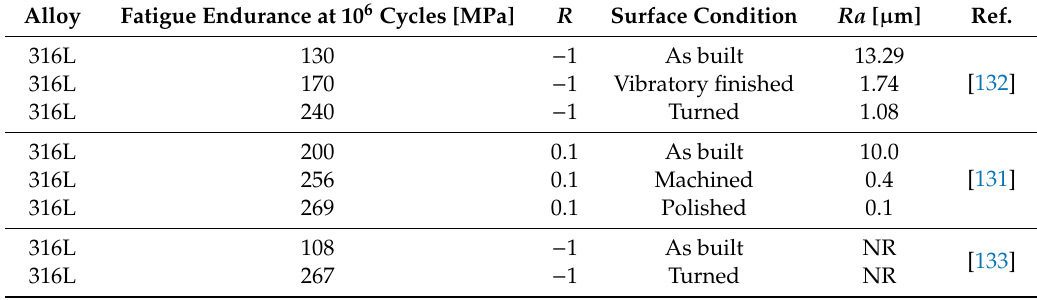
Table 3. Fatigue endurance limits of L-PBF 316L samples, under di ff erent loading and surface conditions.